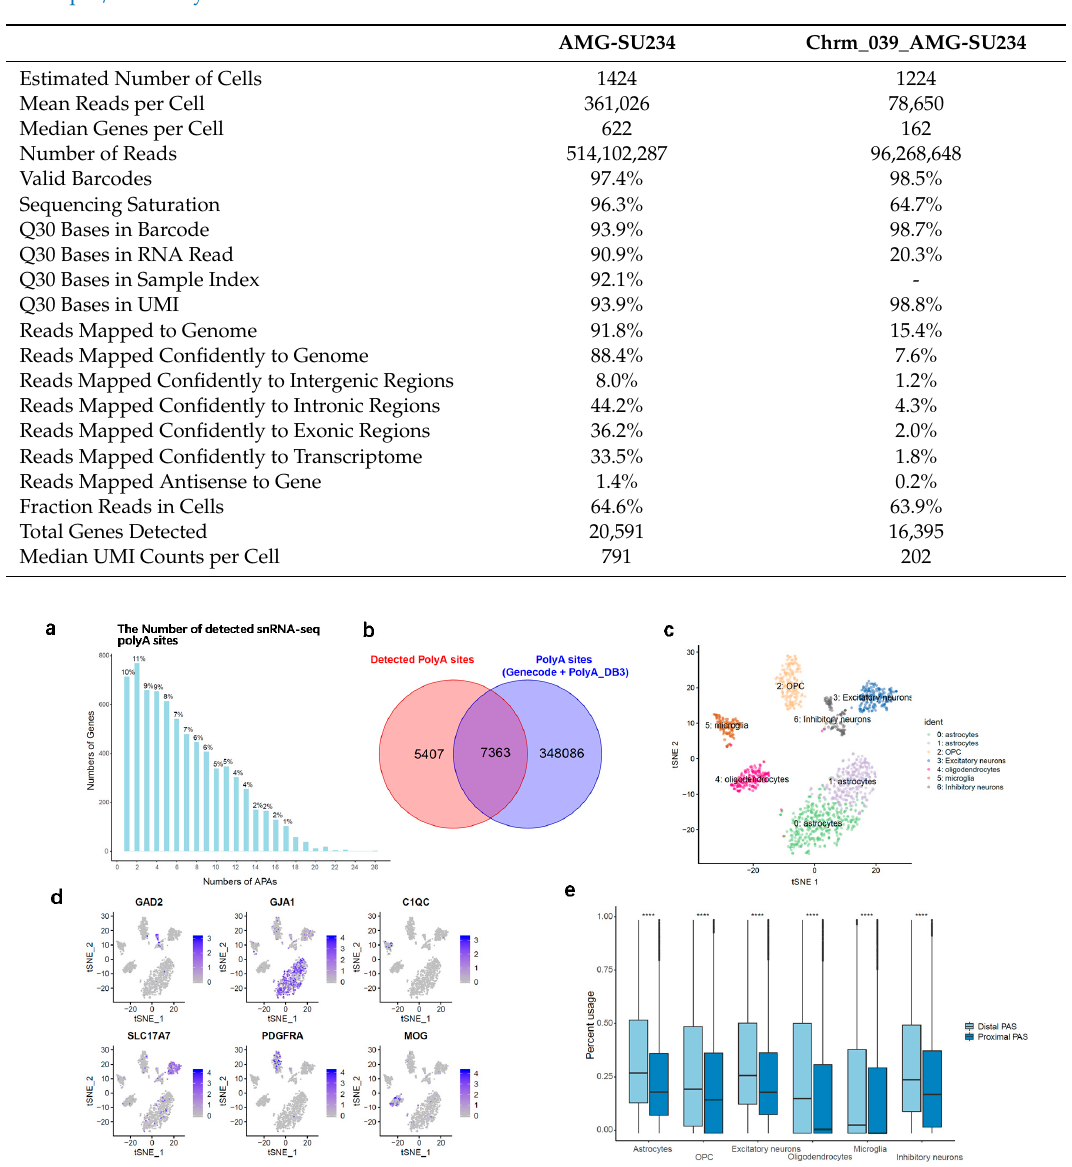
Figure 1. Single-nucleus alternative polyadenylation (APA) evaluation. ( a ) Distribution of poly(A) sites per gene; ( b ) Detected snRNA-seq poly(A) sites overlap with poly(A) annotation for protein coding genes; ( c ) Cell type identification; ( d ) Marker genes expression; ( e ) Distribution of percent usage of distal and proximal PAS (relative to 5’ end), which were selected from the top 2 most used APAs for each gene. **** p -value <